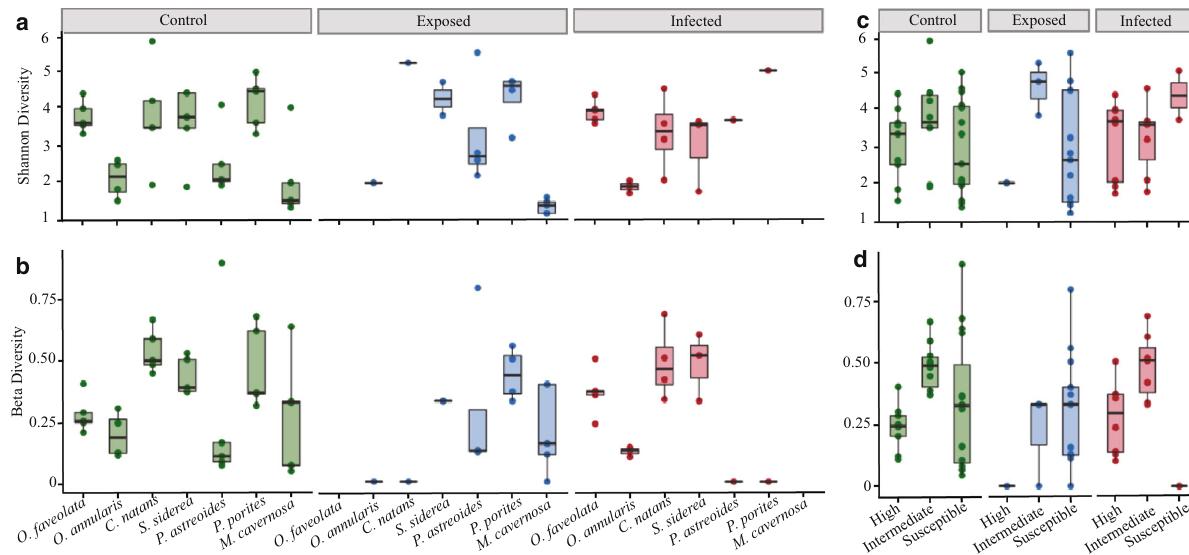
Fig. 8 Microbiome diversity. a Alpha diversity (Shannon diversity) and ( b ) Beta diversity (local diversity) per species and ordered by species disease susceptibility from left to right; and grouped by treatment outcome: control, exposed, and infected. c , d Alpha and Beta diversity grouped by species susceptibility ( O. faveolata , O. annularis are high susceptibility, C. natans and S. siderea are intermediate susceptibilities, P. astreoides , P. porites , and M. cavernosa are in low